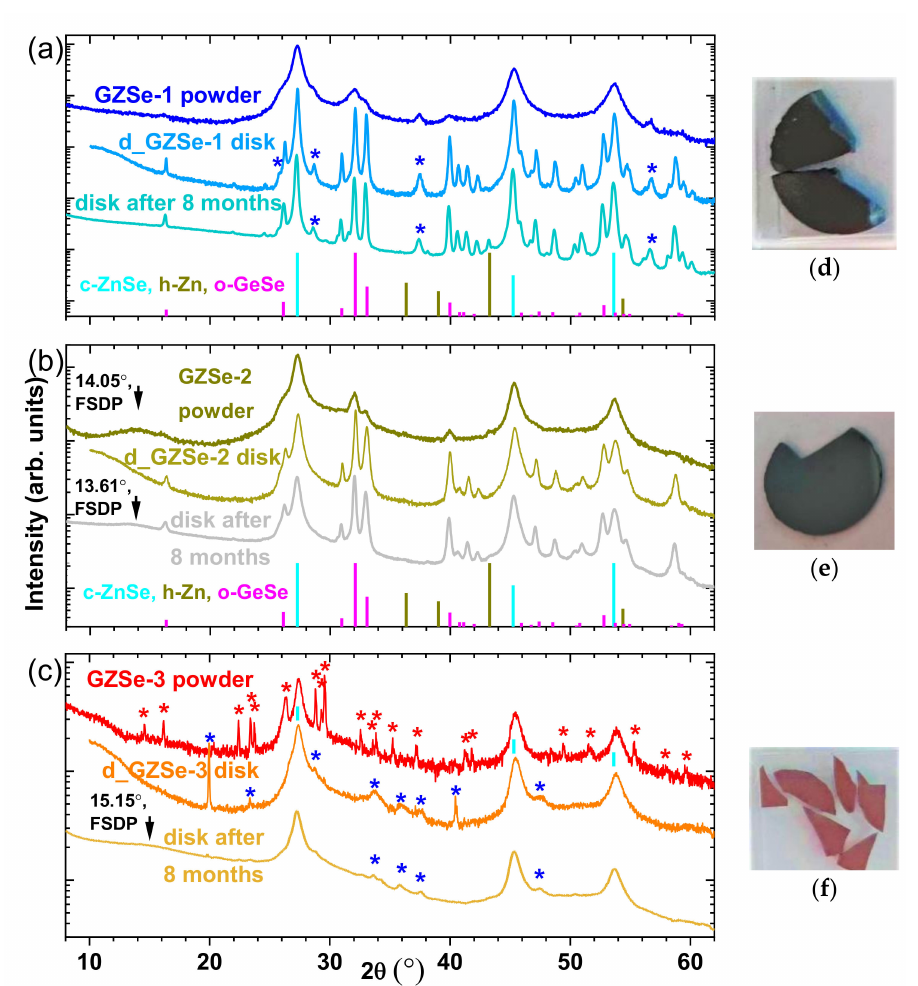
Figure 3. X-ray diffraction patterns of the sintered chalcogenide samples ( a ) d_GZSe-1, ( b ) d_GZSe-2, and ( c ) d_GZSe-3 obtained by Spark Plasma Sintering method, compared to those of the powders from which they were fabricated. The XRD measurements on bulk samples were repeated after 8 months of storage in the ambient atmosphere. The intensity is represented in logarithmic scale to make more visible the low intensity peaks, and the XRD patterns are expanded on the y-axis scale for clarity. The peaks of the unidentified phases were indicated with “*”. The optical images of the polished disk fragments ( d ) d_GZSe-1, ( e ) d_GZSe-2, and ( f )